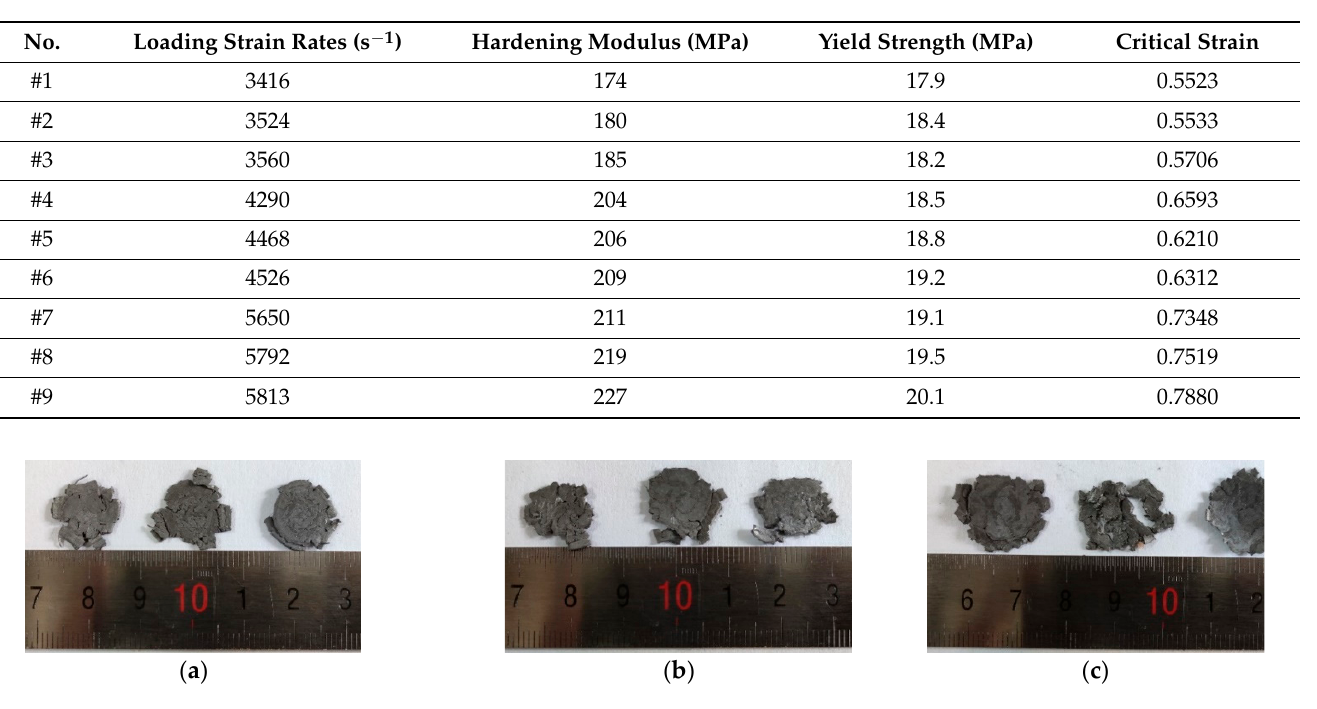
Figure 10. The recycled sample under different loading strain rates: ( a ) 3500 s − 1 ; ( b ) 4500 s − 1 ; ( c ) 5500 s − 1 .